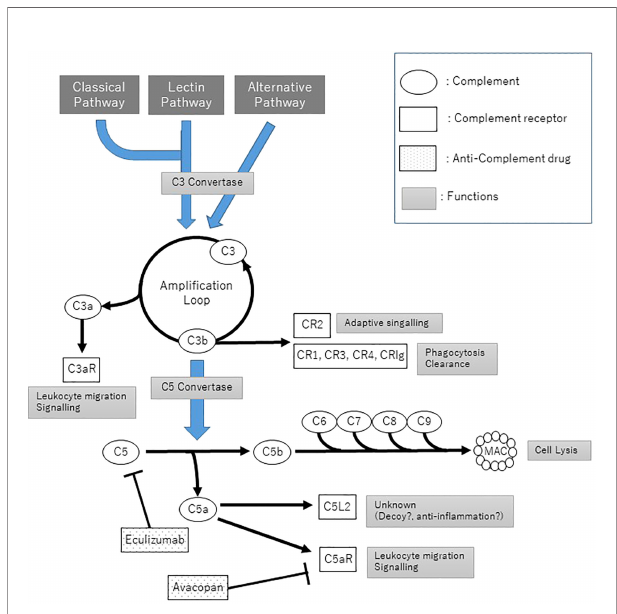
FIGURE 1 | The Complement pathways and anti-complement treatment. C3 convertase: C4bC2a for classical pathway and lectin pathway, C3bBb for alternative pathway; C5 convertase: C4bC2aC3b and